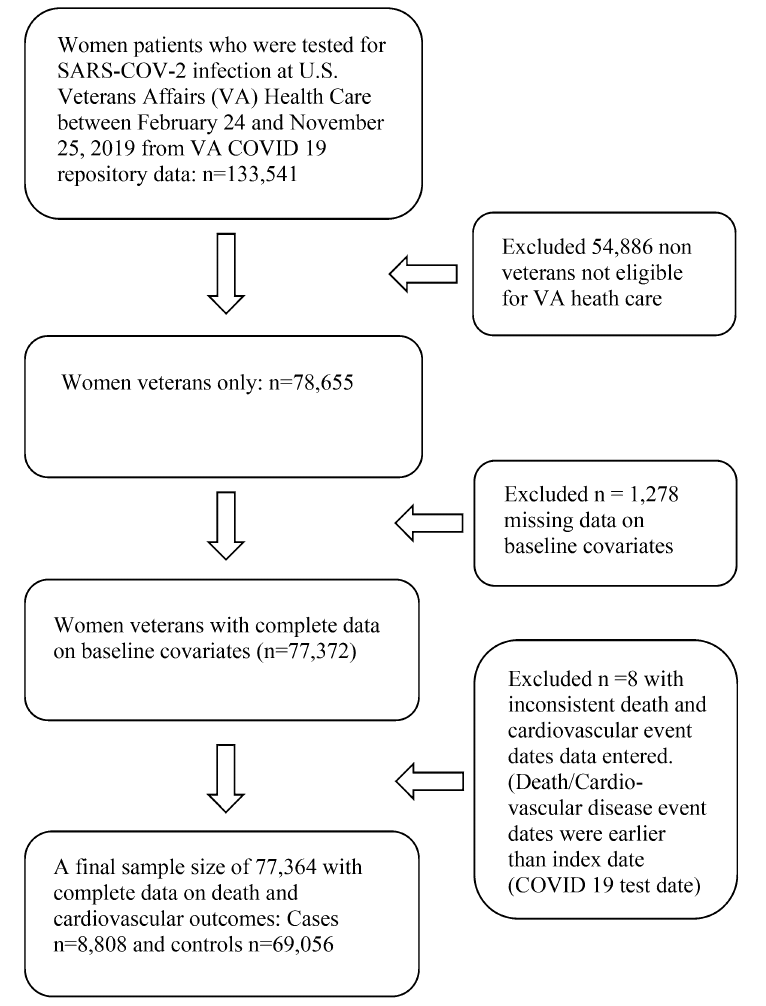
Figure 5. Procedure of inclusion and exclusion of the study